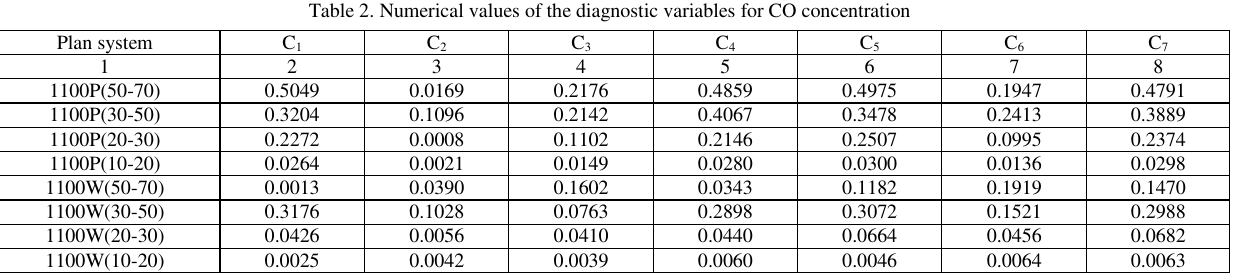
Table 2. Numerical values of the diagnostic variables for CO concentration